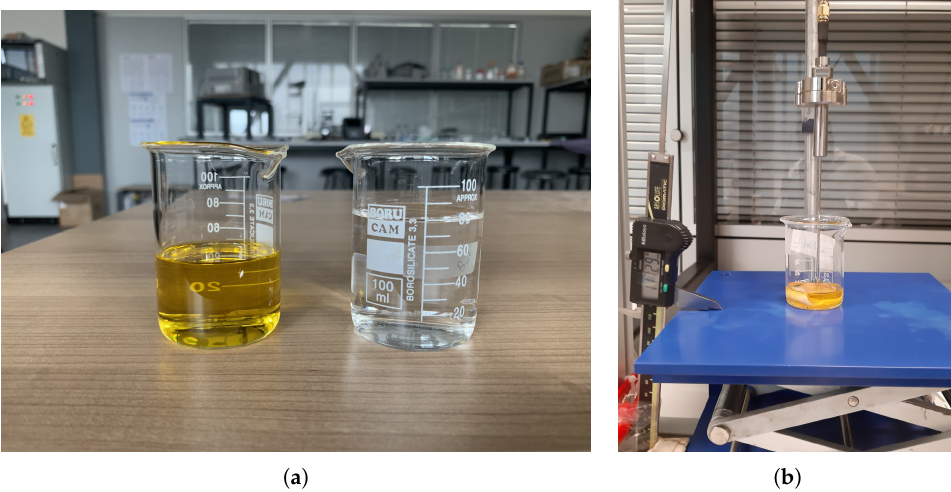
Figure 6. Sample configuration: ( a ) olive oil (left) and Triton X-100 (right) were used as second layer liquids and ( b ) double-layered configuration with rat breast tissue and olive oil.